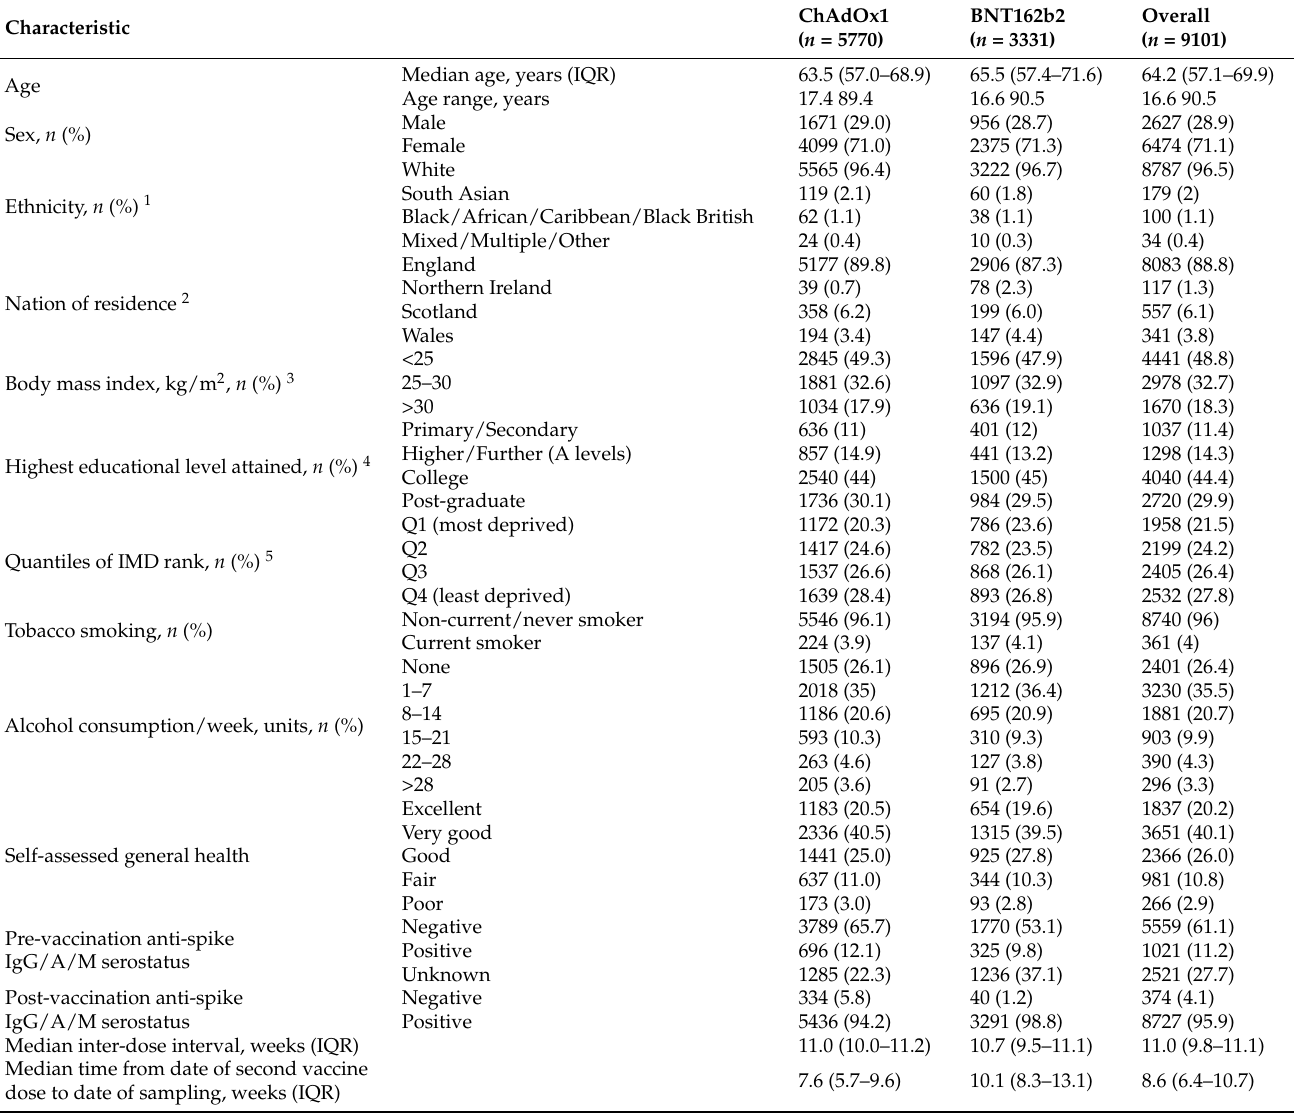
Table 1. Participant characteristics, by vaccine type and overall ( n =